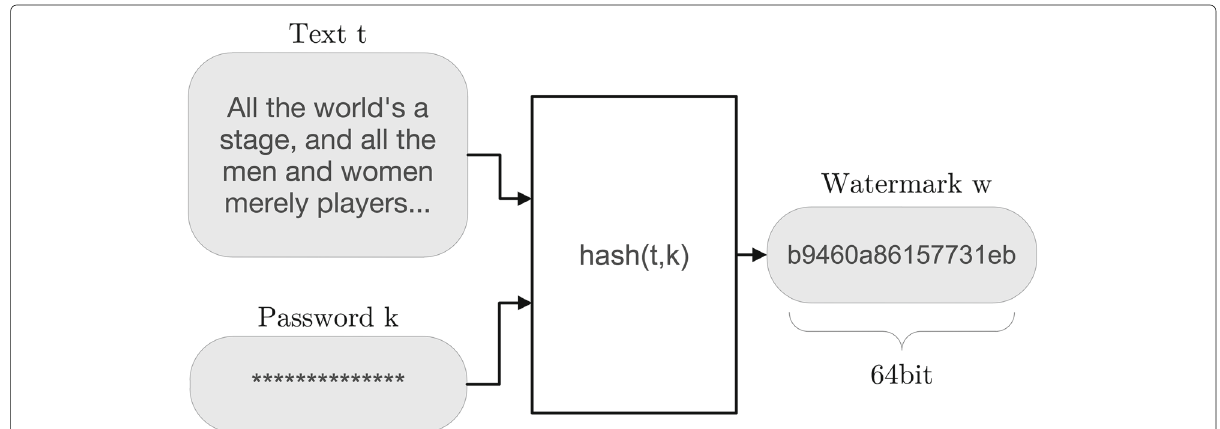
Fig. 1 Generation of the watermark bits. Given the original text t and a secret password k , the SipHash function generates a cryptographic hash, representing the watermark w to be